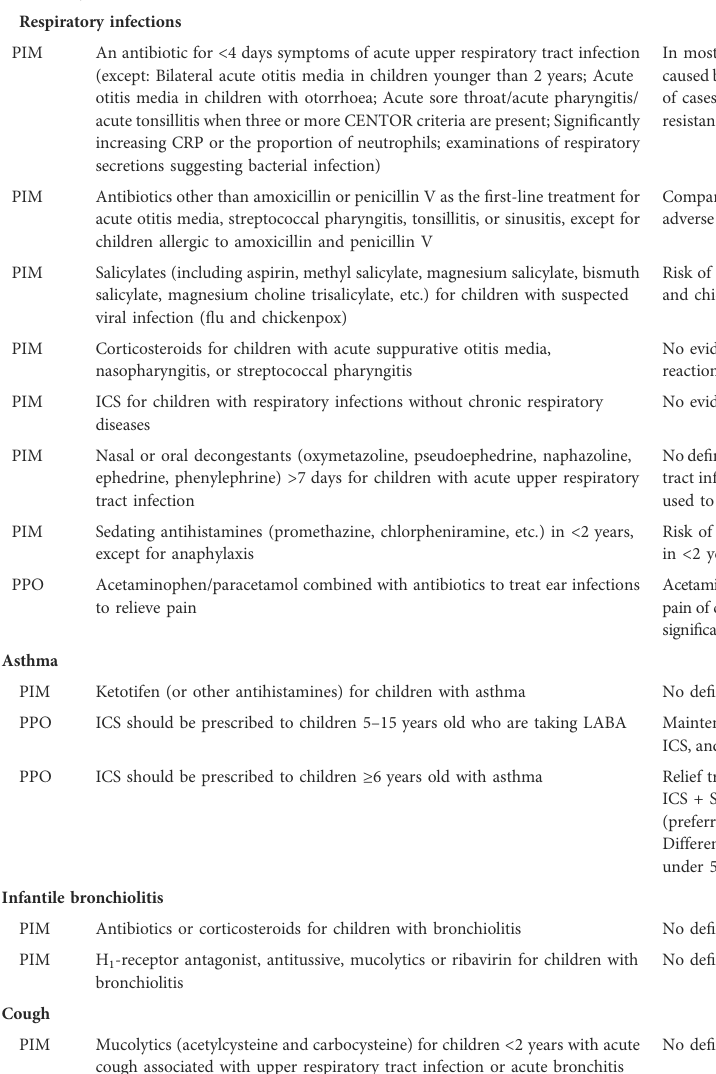
TABLE 2 PIP criteria for children with speci fi c